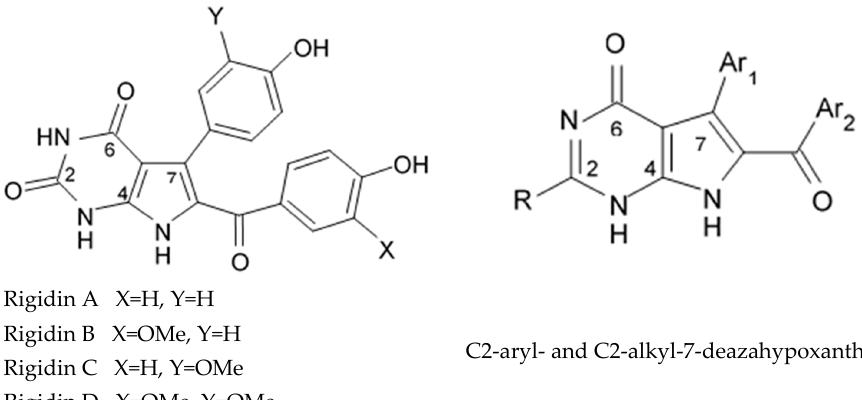
Figure 4. Structures of the marine alkaloid rigidins A, B, C, D, and their 7-deazahypoxanthine based synthetic analogues [79].